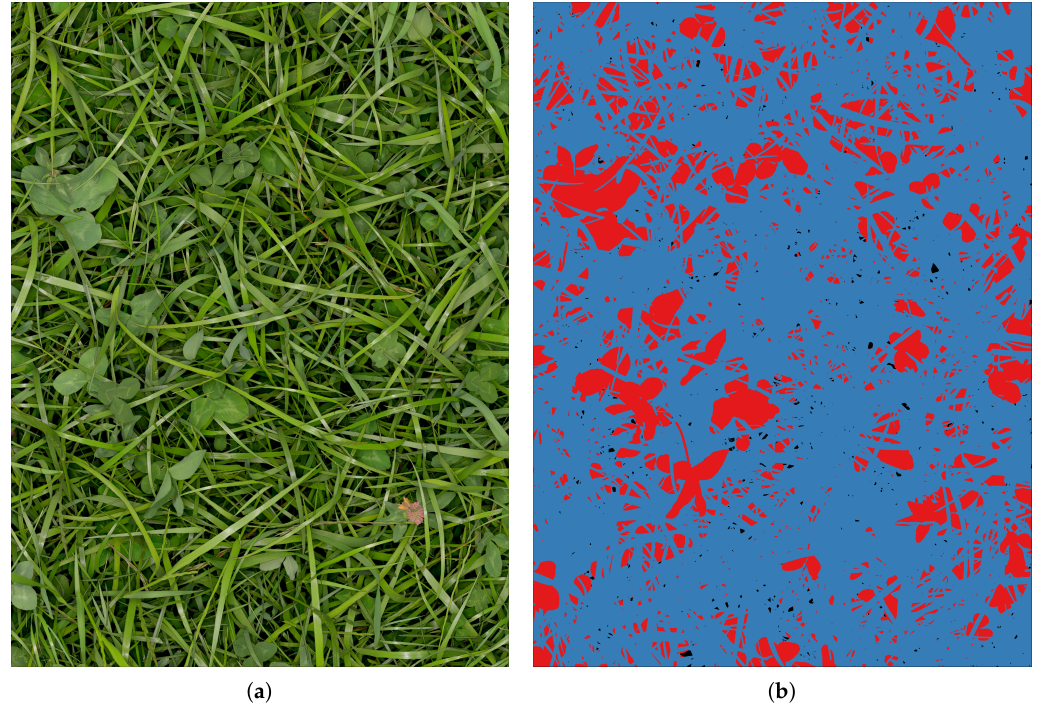
Figure 6. Simulated training data pair. ( a ) Simulated red, green, and blue (RGB) image; ( b ) Corresponding label image. Grass, clover and soil pixels in the RGB image are denoted by blue, red and black pixels in the label image,